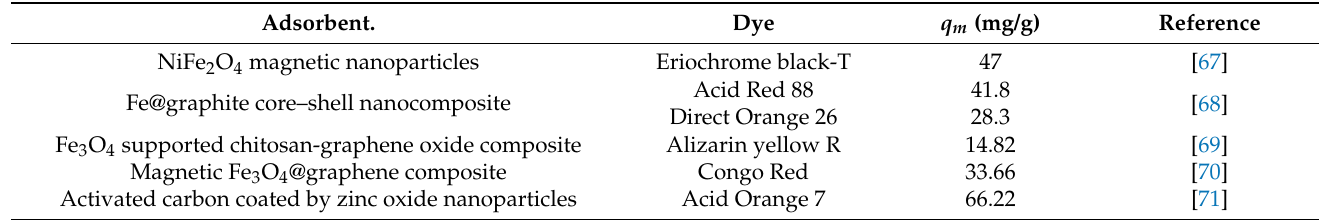
Table 10. Comparison of the maximum adsorption capacity of anionic dyes onto magnetic nanocomposites.